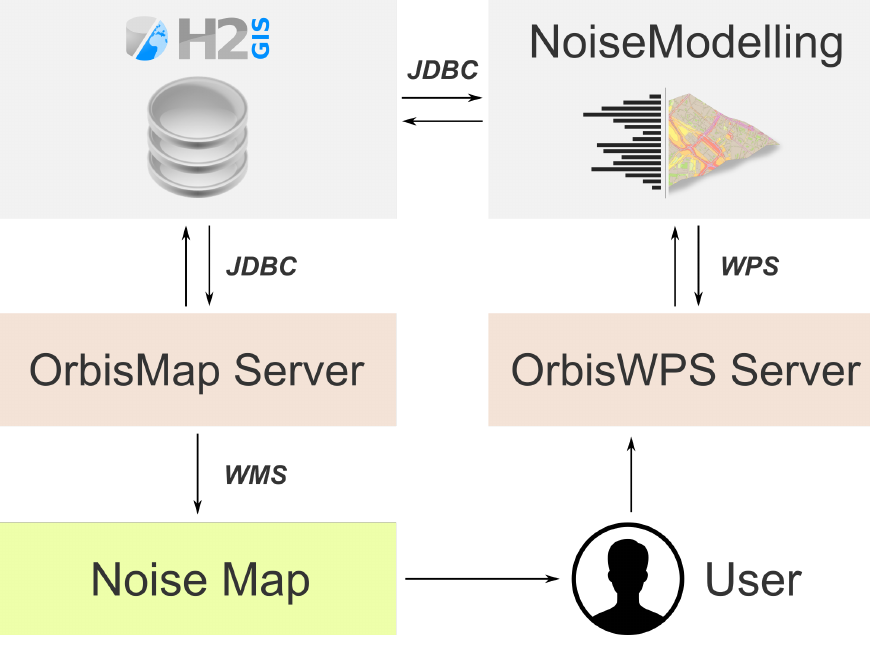
Figure 7. NoiseModelling web service architecture.